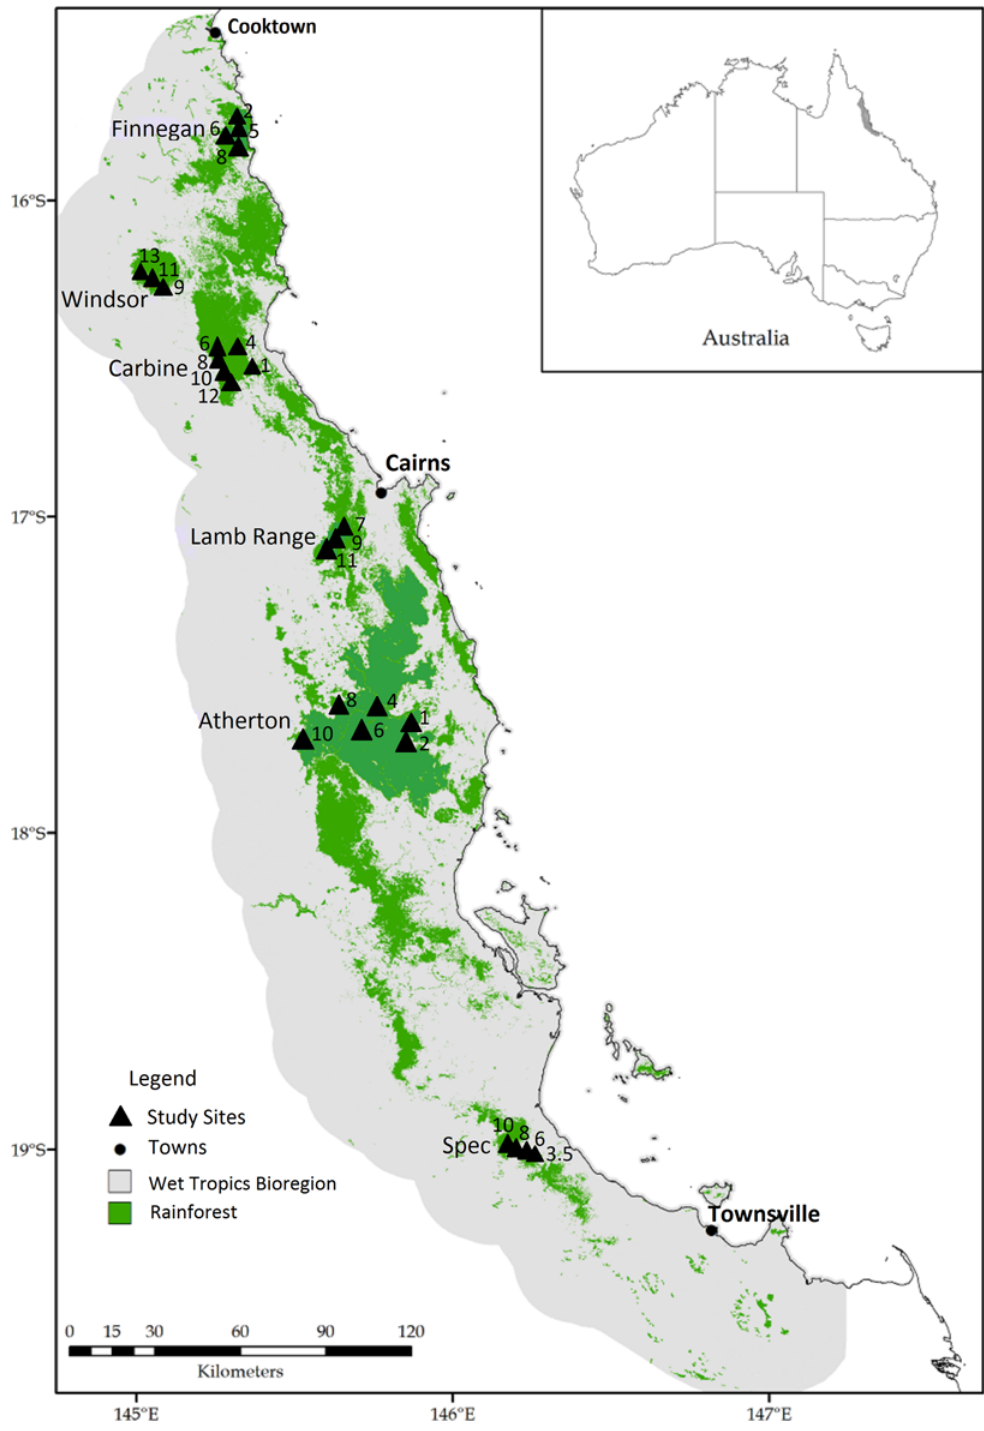
Fig 1. Map showing the current extent of rainforest (green shading) in the Australian Wet Tropics bioregion (grey shading), with locations of sampling sites indicated by triangles, with numbers representing elevation ( ‘ 00 m a.s.l.). Reprinted from [15] under a CC BY license, with permission from Kyran M. Staunton, original copyright